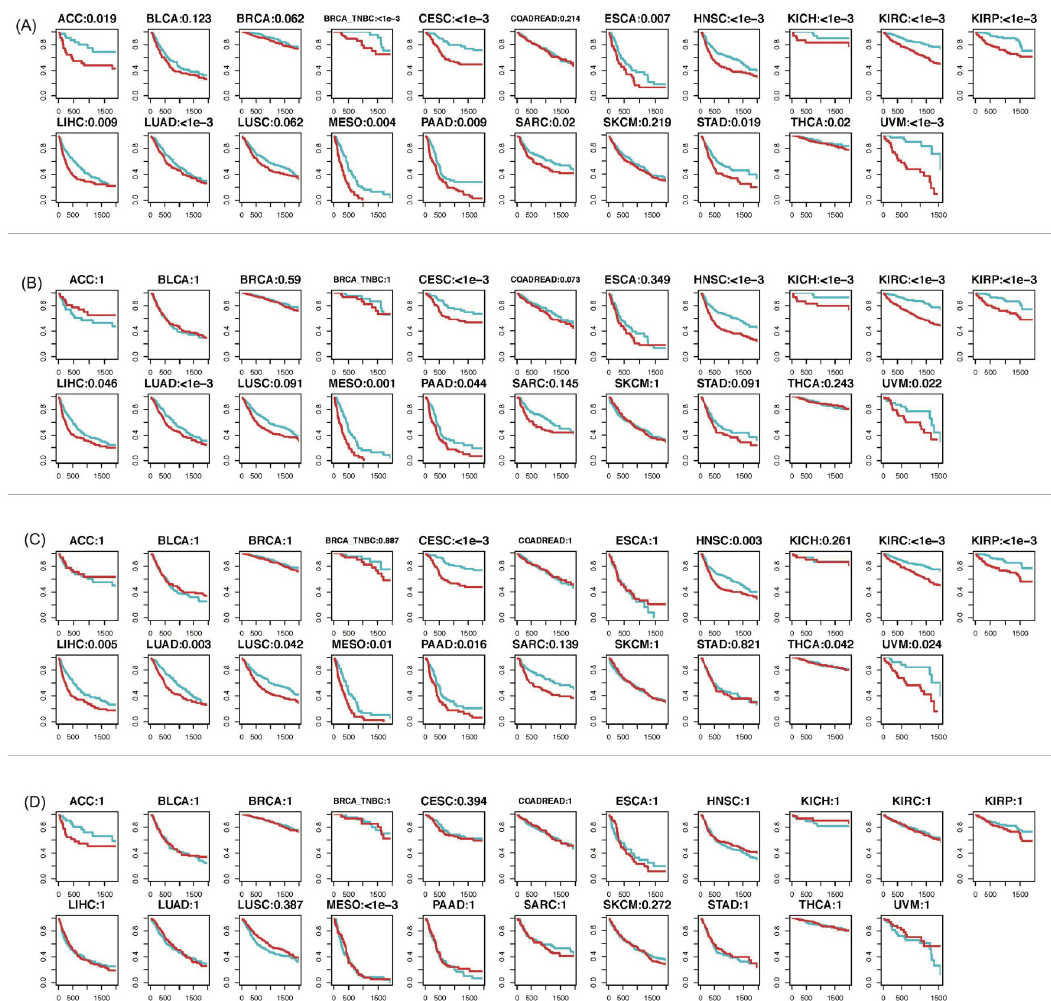
Fig 3. Progression-free survival curves of patients with different metastasis potentials. Higher metastasis potential (red) and lower metastasis potential (blue) for 21 cancer (sub)types are predicted by (A) PLUS; (B) PLR; (C) PUlasso; and (D) XGBoost. The x -axis represents time in days and y -axis represents the percentage of patients without metastasis event at a particular time point. Note, the p -value shown above each figure panel is calculated between the predicted continuous metastasis potential with the progression-free survival (PFS); the blue and red curves shown in the figure, however, represent patient groups that are dichotomized at the median of the predicted metastasis